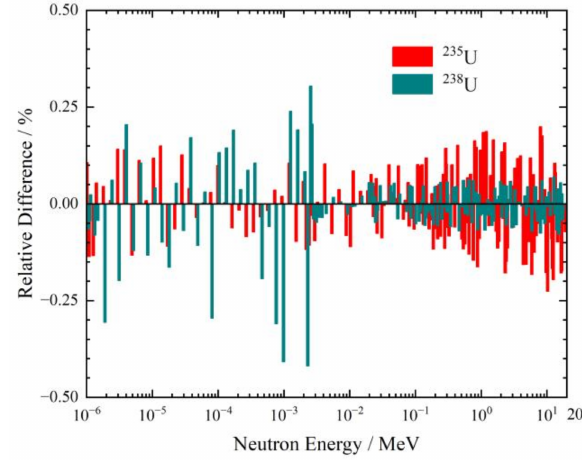
Figure 2. The relative differences of background cross-sections.